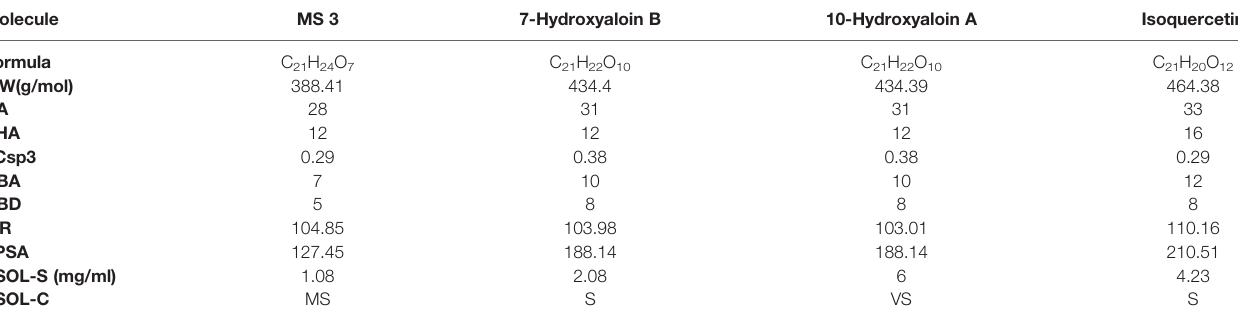
TABLE 5 | Physiochemical properties of the lead phytochemicals. Molecule MS 3 Formula